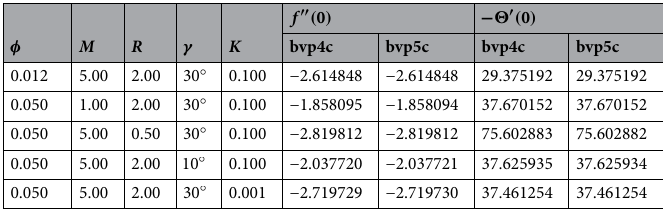
Table 1. validation of results for Pr = 6.2